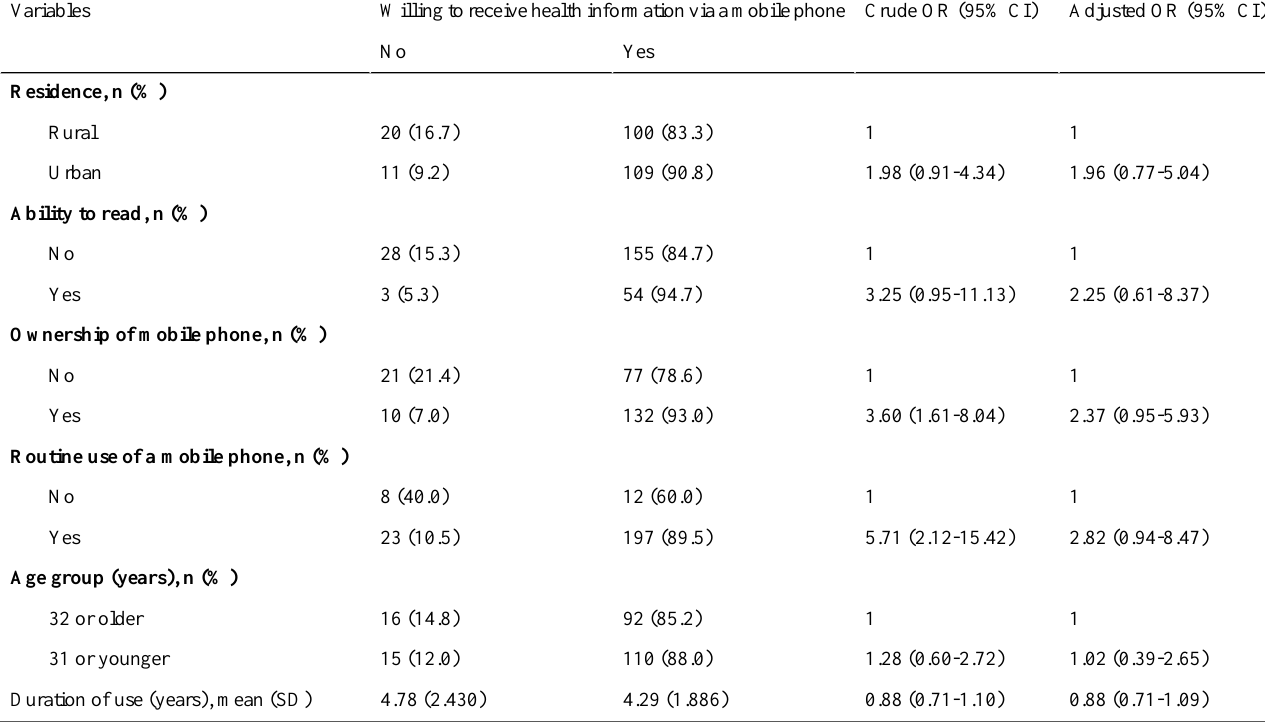
Table 5. Factors associated with willingness to receive health information via a mobile phone (N=240). OR: odds